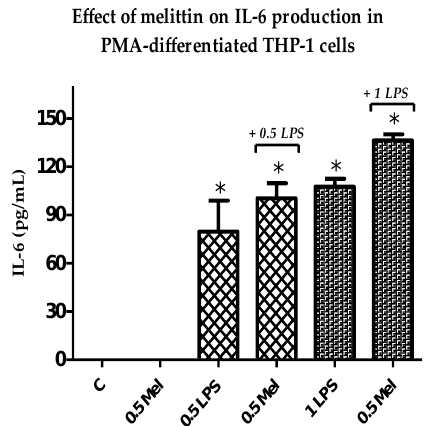
Figure 4. Effect of melittin on the production of IL-6 cytokine in the presence and absence of LPS on PMA-differentiated THP-1 cells. Melittin was tested at a 0.5 µg/mL final concentration in combination with LPS (0.5 and 1 µg/mL) ( n = 3). C: control; Mel: melittin; LPS: lipopolysaccharide; *: Significant ( p < 0.05) compared to negative control cells.